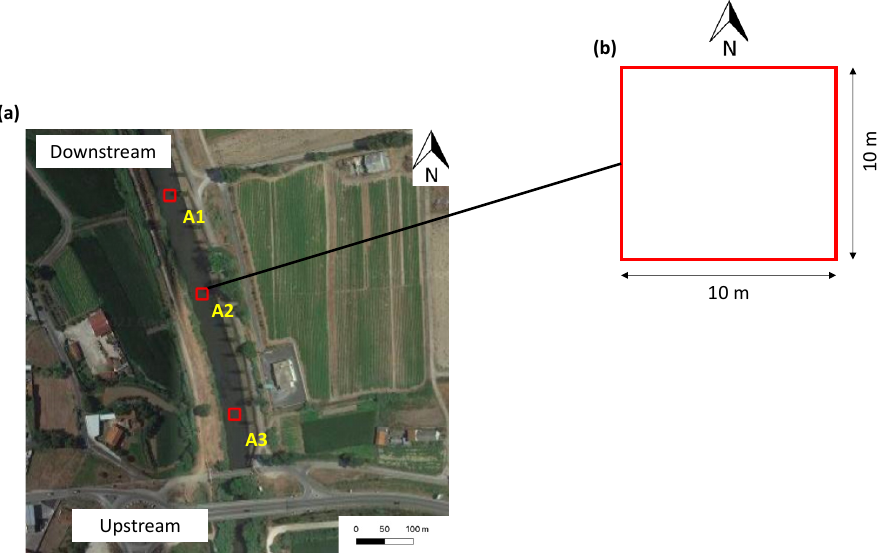
Figure 4. Observing the invasive aquatic plant Lemna minor in a section of the Lis River, near Monte Real (Portugal): ( a ) Location of the three sample areas (red squares: A1, A2, A3; markers are not to scale) on the river water surface. ( b ) Diagram of a typical quadrangular sample area, of 100 m 2 .